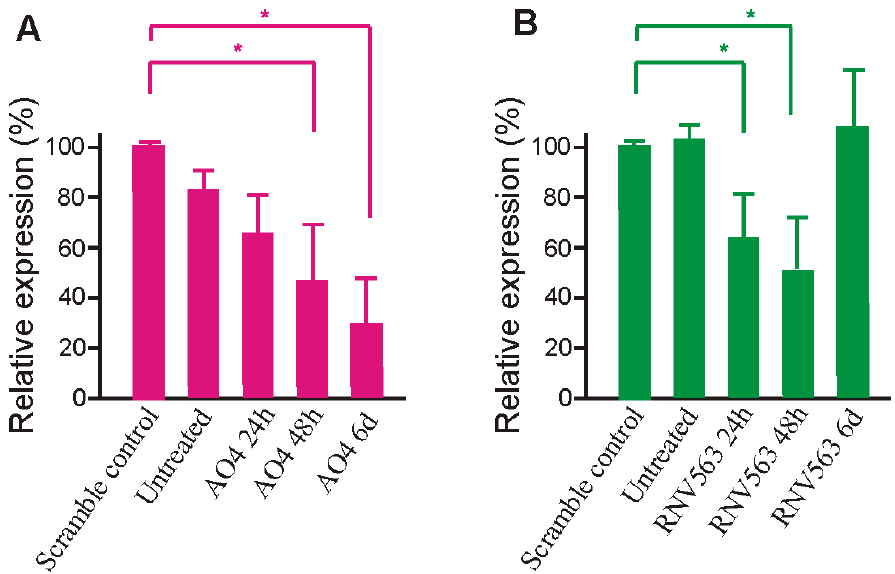
Figure 6. ( A ) Densitometry analysis of the tau expression obtained from western blot (three replicates) analysis after the treatment of SH-SY5Y cells with AO4 at 50 nM concentrations and incubation of AO4 for 24 h, 48 h, and six days. SH-SY5Y cells were treated with the scrambled control at a 50 nM concentration and incubation of six days. AO4 targets exon 4 of the MAPT transcript. The error bars represent the standard error of the mean. ( B ) Densitometry analysis of the tau expression obtained from western blot (three replicates) analysis after the treatment of SH-SY5Y cells with RNV563 at 400 nM concentrations and incubation of DNAzyme for 24 h, 48 h, and six days. SH-SY5Y cells were treated with the scrambled control at a 400 nM concentration and incubation of six days. RNV563 targets exon 9 of the MAPT transcript. The error bars represent the standard error of the mean.